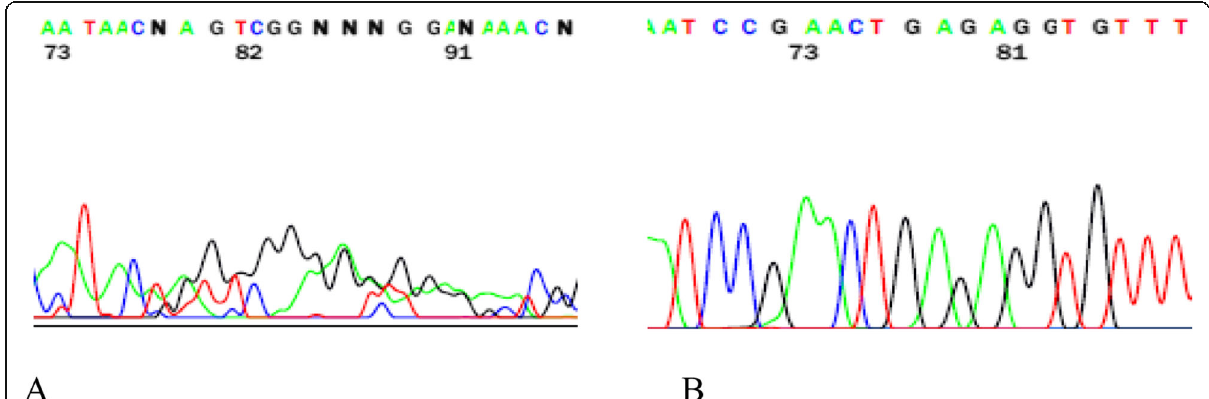
Fig. 3 Partial sequence alignment of the 16 s rDNA variable V9 and universal U6 regions of H. pylori isolates from Egyptian patients that are 100% homologous among H. pylori ATCC 43504 and H. pylori NCTC11637 reference strains. Dots indicate the identity with the reference strains and letters indicate the base substitution. Isolates specify three individual 16S rDNA V9 alleles (signature sequences) at positions 1239 – 1260 ( Escherichia coli nomenclature (DSRG (DNA Sequencing Research Group)